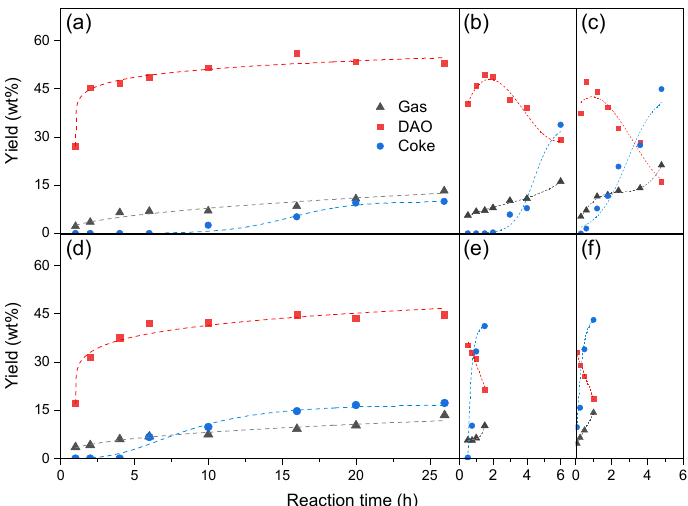
Figure 2. Yields for gas, deasphalted oil (DAO), and coke in catalytic hydrocracking of C5-Asp at ( a ) 380, ( b ) 410, and ( c ) 430 ◦ C and non-catalytic hydrocracking of C 5 -Asp at ( d ) 380, ( e ) 410, and ( f ) 430 ◦ C. Reaction conditions: batch reactor, P H2 = 80 bar at 80 ◦ C, and 1000 wppm of Mo from Mo-octoate in catalytic hydrocracking.